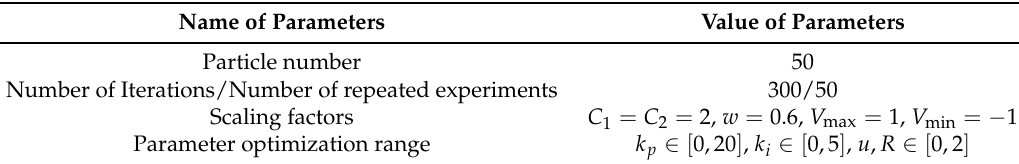
Table A2. PSO optimization algorithm configuration.